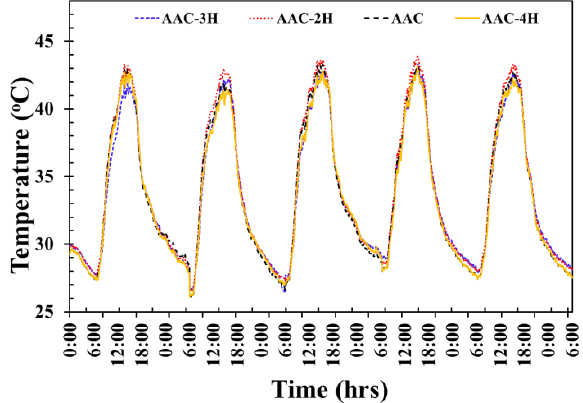
Figure 14. Room temperature of the 4 testing rooms in real weather.